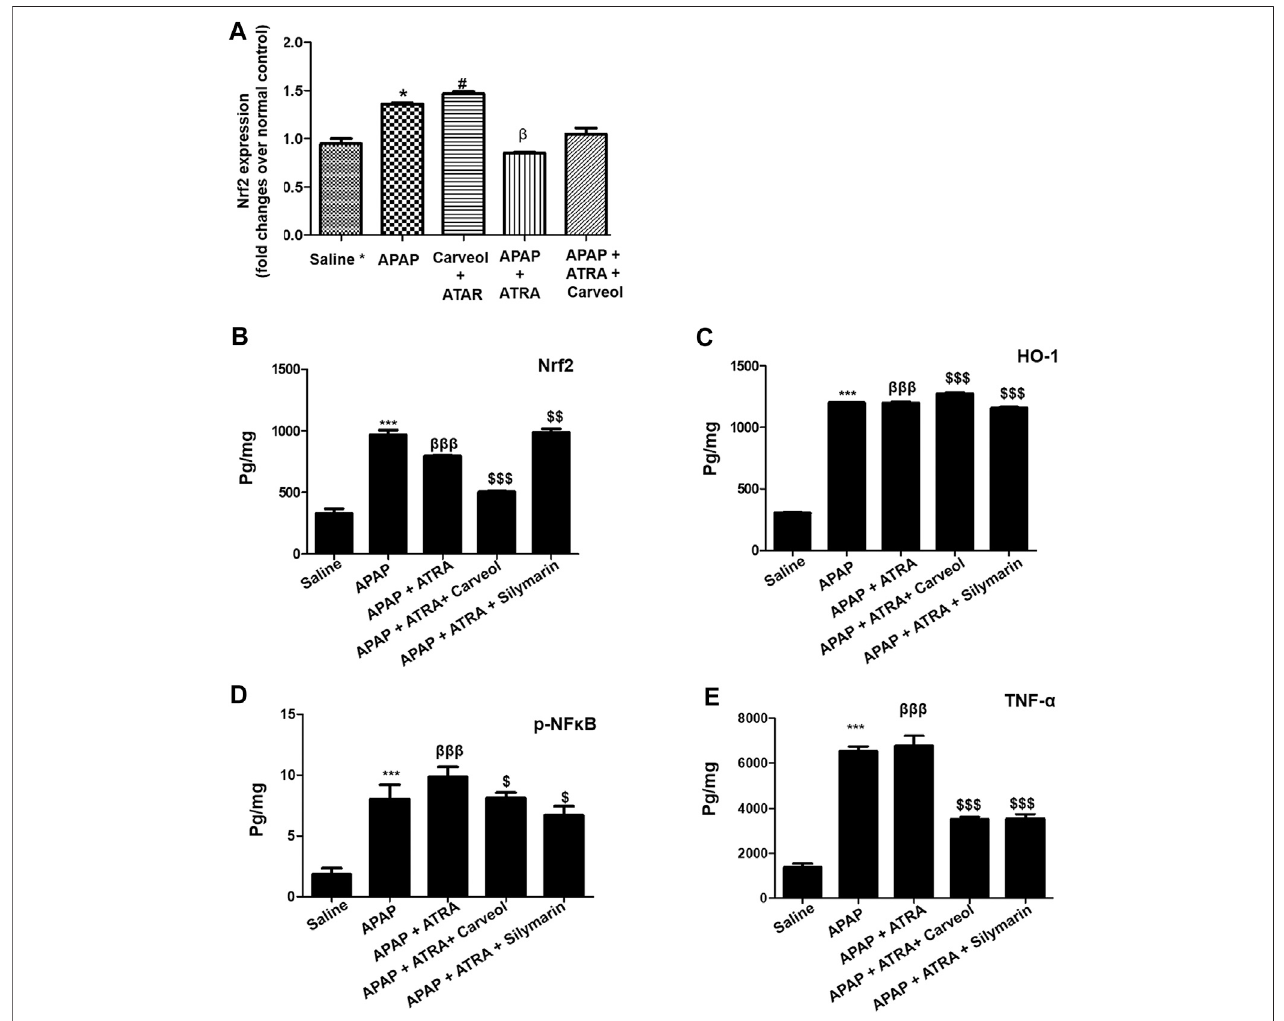
Figure 7 | Carveol produces Nrf2-dependent effects. (A) qPCR analysis, (B) Nrf2 (C) HO-1, (D) p-NF κ B, and (E) TNF- α were quanti fi ed using ELISA. The data are expressed as mean ± SEM and were analyzed using one-way ANOVA followed by Tukey ’ s multiple comparison test, and n (cid:1) 5/group. The symbols ppp , βββ and represent signi fi cant difference values of p < 0.001, while the symbol $ represents signi fi cant difference values of p < 0.05. The symbol p or β represents a signi fi cant differencerelativetosaline,while$representsasigni fi cantdifferencerelativetotheAPAP+ATRAgroup.Thesampleswerecollected6 hlater,forbiochemicaland morphological analyses. The samples were processed from cohort 2.